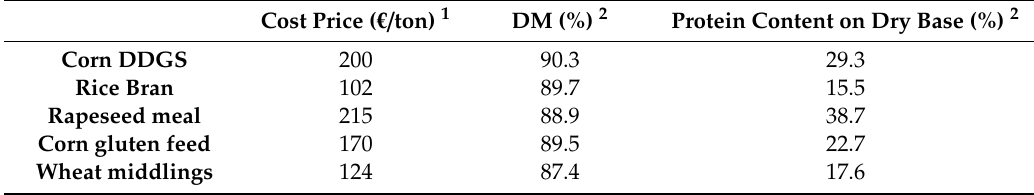
Table 1. Side-streams from the agri-food sector considered in this study. DM: dry matter.